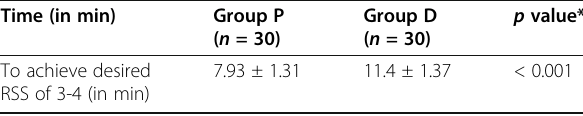
Table 3 Rescue drug used Rescue drug used (Inj. propofol